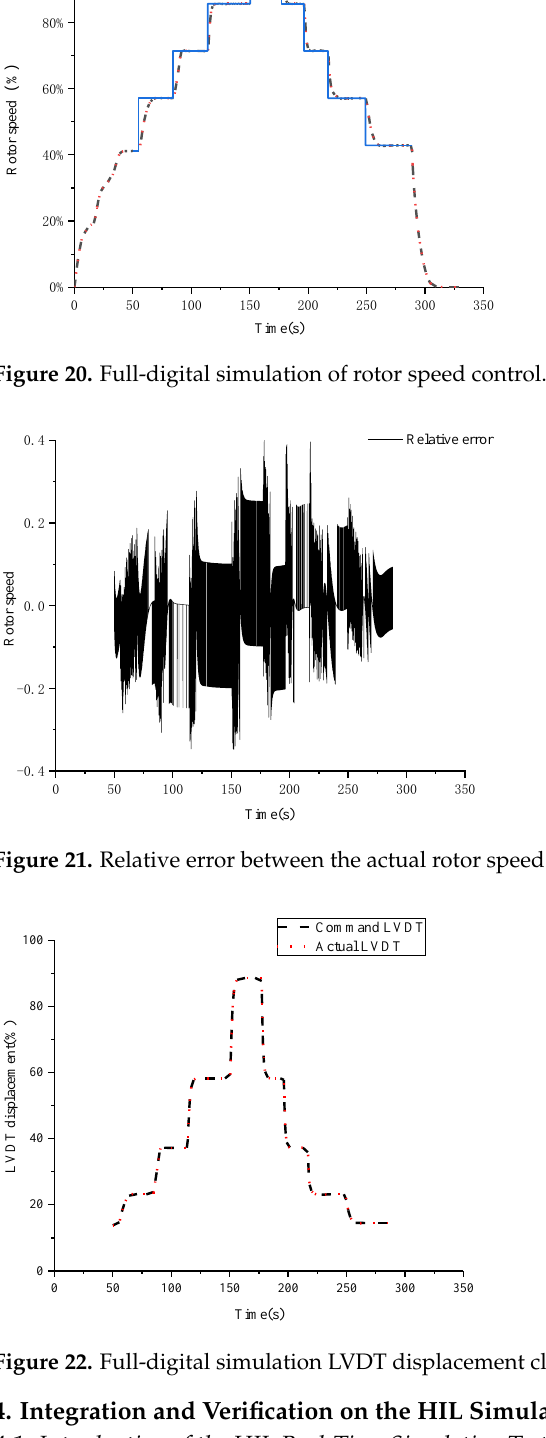
Figure 22. Full-digital simulation LVDT displacement closed loop control.